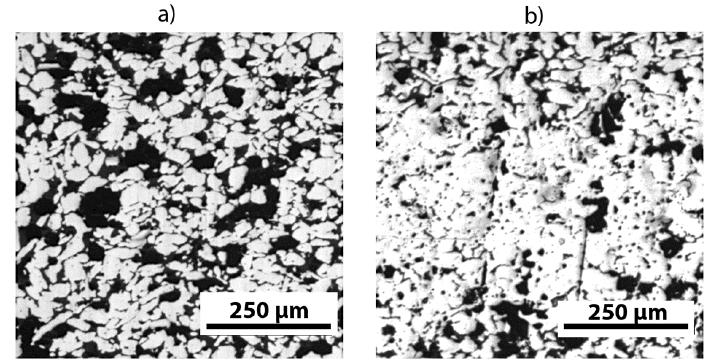
Figure 2. Optical micrographs registered for ( a ) sample A and ( b ) sample B. Sintered pellet dimensions: 3 mm (height) and 13 mm (diameter).